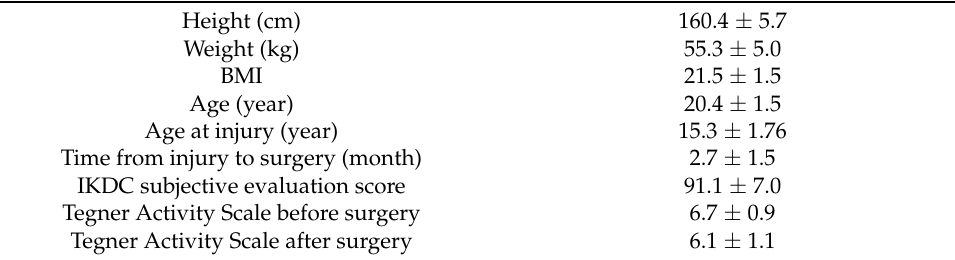
Figure 2. Flowchart for subject selection. ACL, anterior cruciate ligament. Table 1. Demographic data of the subject.